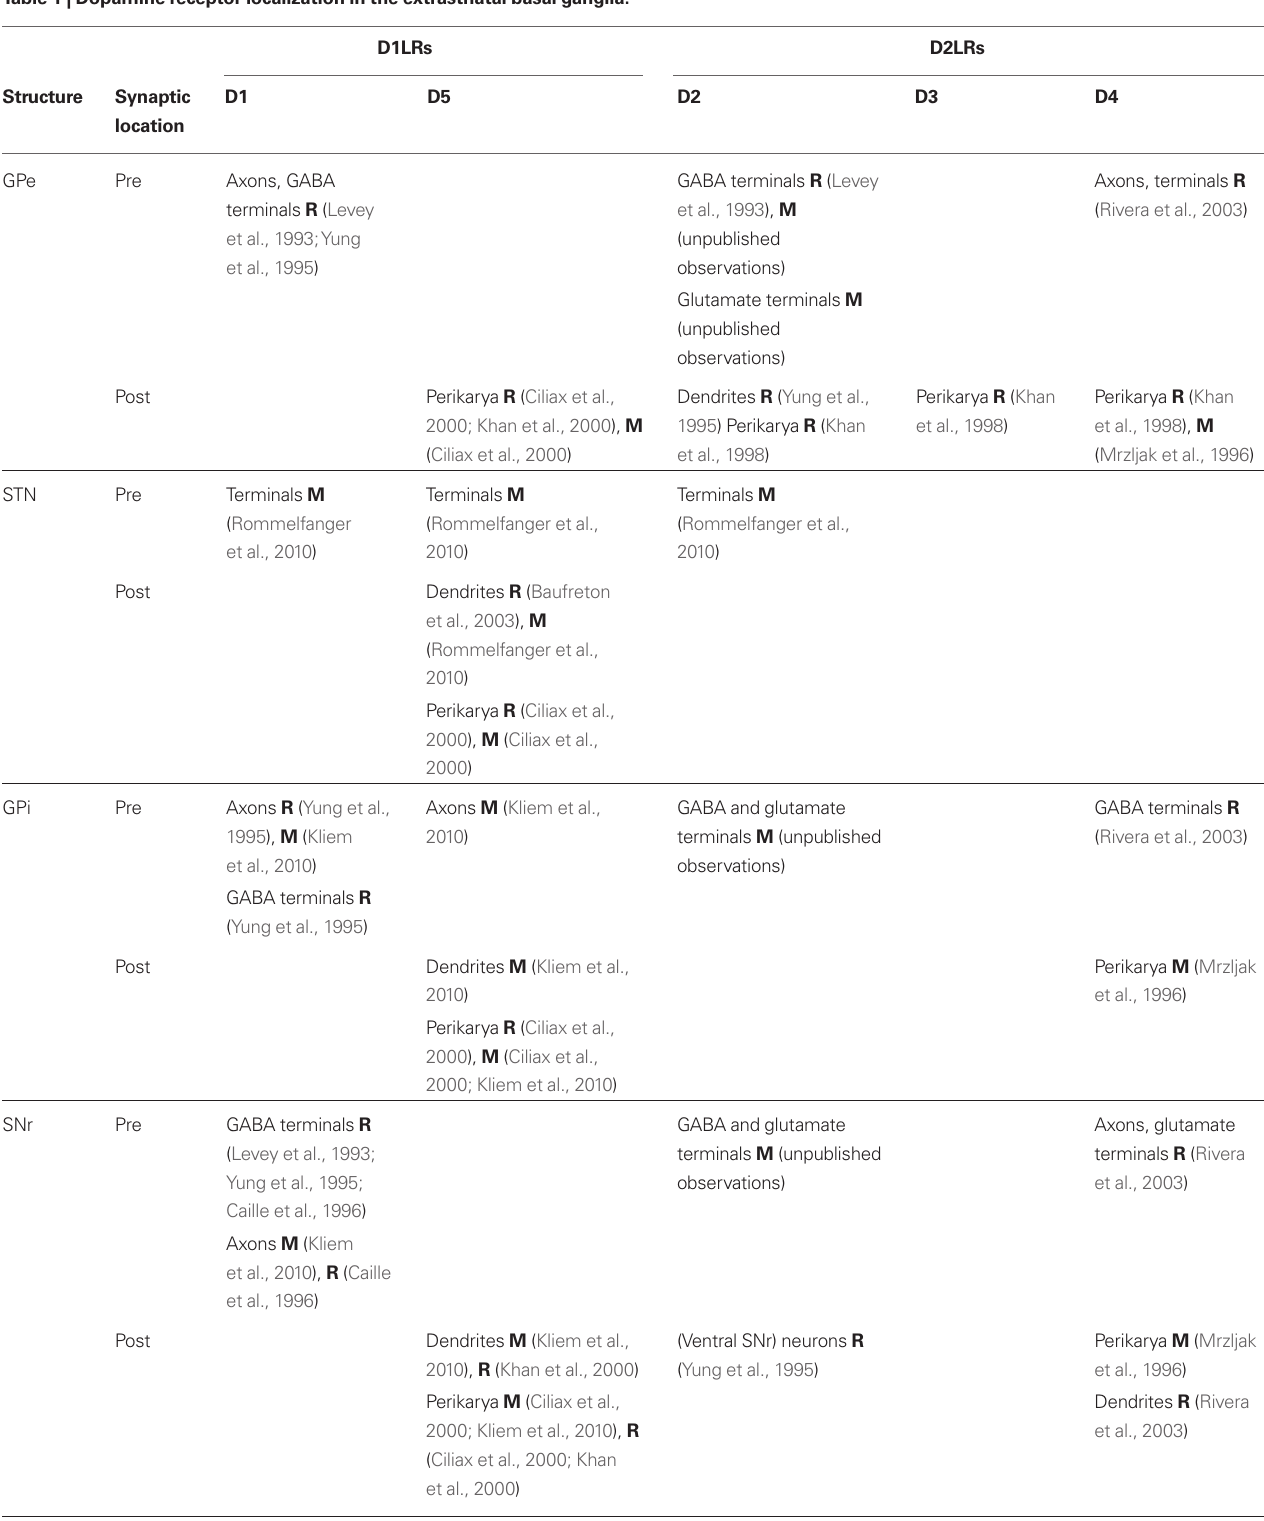
Table 1 | Dopamine receptor localization in the extrastriatal basal